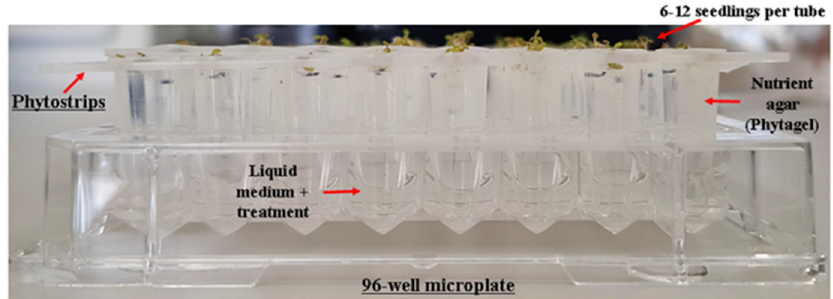
Figure 3. The effect of the EBP-produced chitooligosaccharide (COS) on Arabidopsis thaliana root growth: the scheme of the